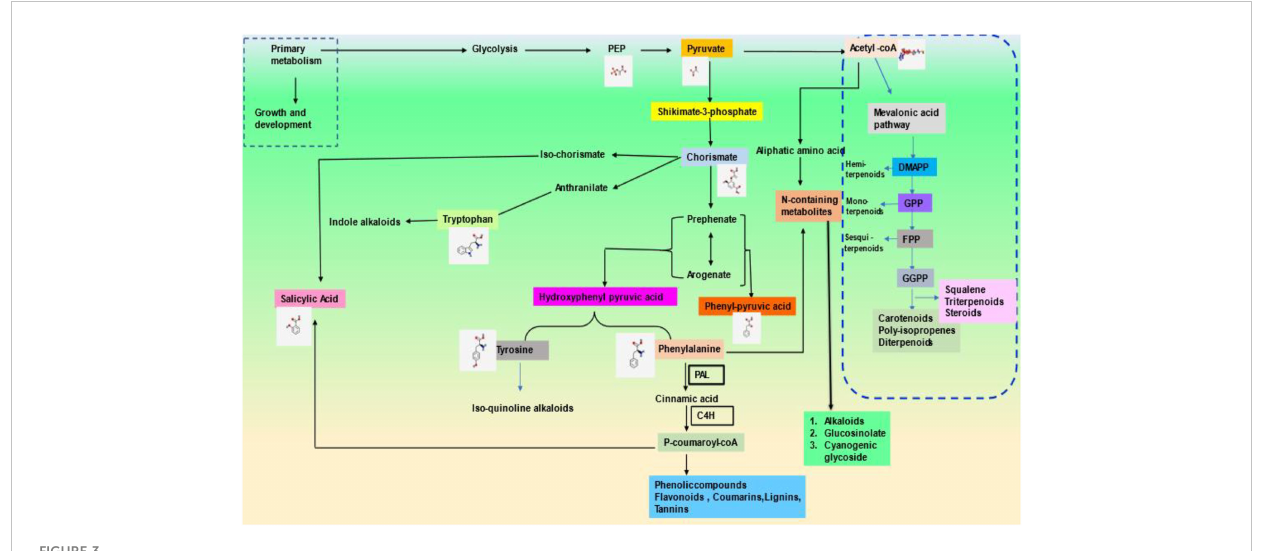
FIGURE 3 An abundance of various Plants TFs in important economic